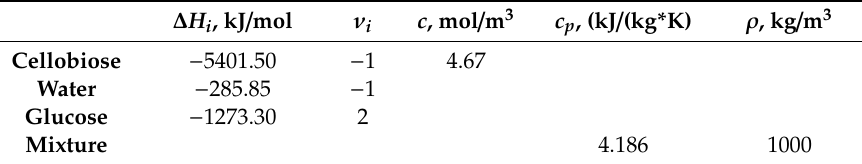
Table 1. Parameters used to calculate the ∆ T ad